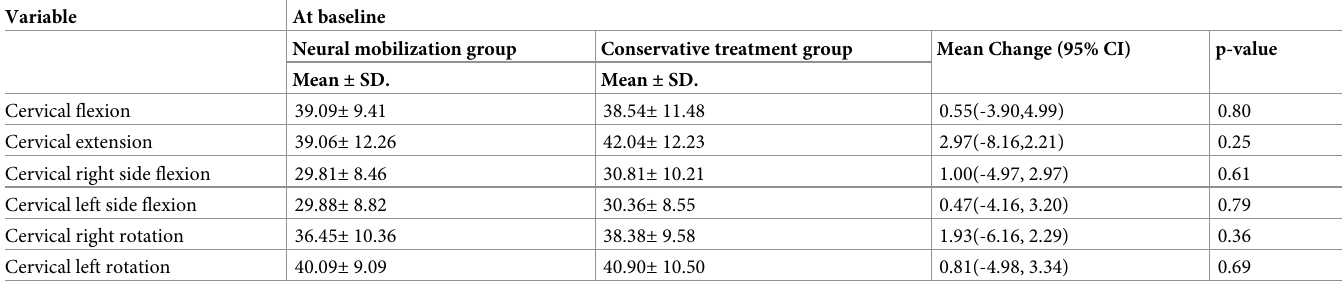
Table 2. Baseline measurement of cervical range of motion